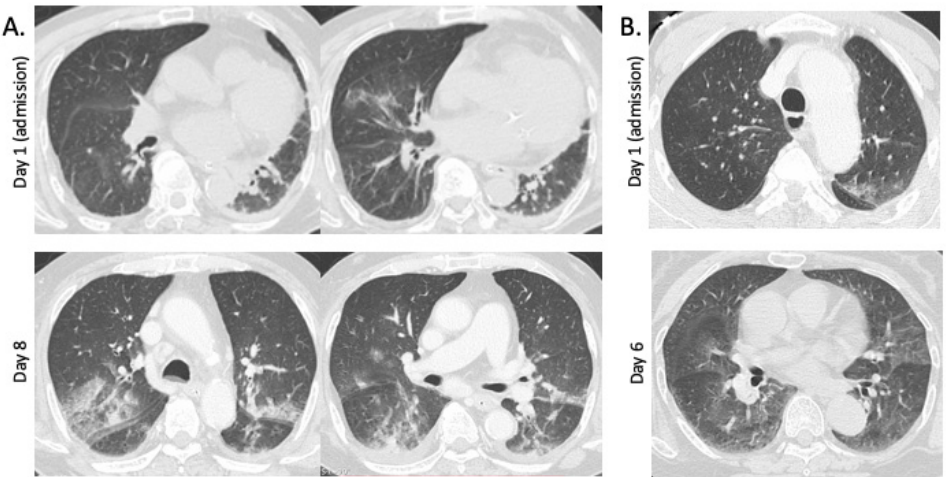
Figure 1. Ground-glass opacities (GGOs) in chest CT in patients with SFTS. ( A ) Chest CT images in a 79-year-old nonfatal male patient. Focal GGOs in the lower lobes of the lungs, interstitial septal thickening, cardiomegaly, and pleural effusion were found at admission (2 days after onset). At day 8 of admission, multifocal GGOs with patchy consolidations are present in both lungs. ( B ) Chest CT images of a 73-year-old fatal female patient. Focal GGO is present at upper lobe of left lung at admission (3 days after onset). Multifocal GGOs, interstitial septal thickening, and cardiomegaly are found at day 6 of admission. Table 2. Correlation of GGO and other abnormal chest CT findings in patients with SFTS.